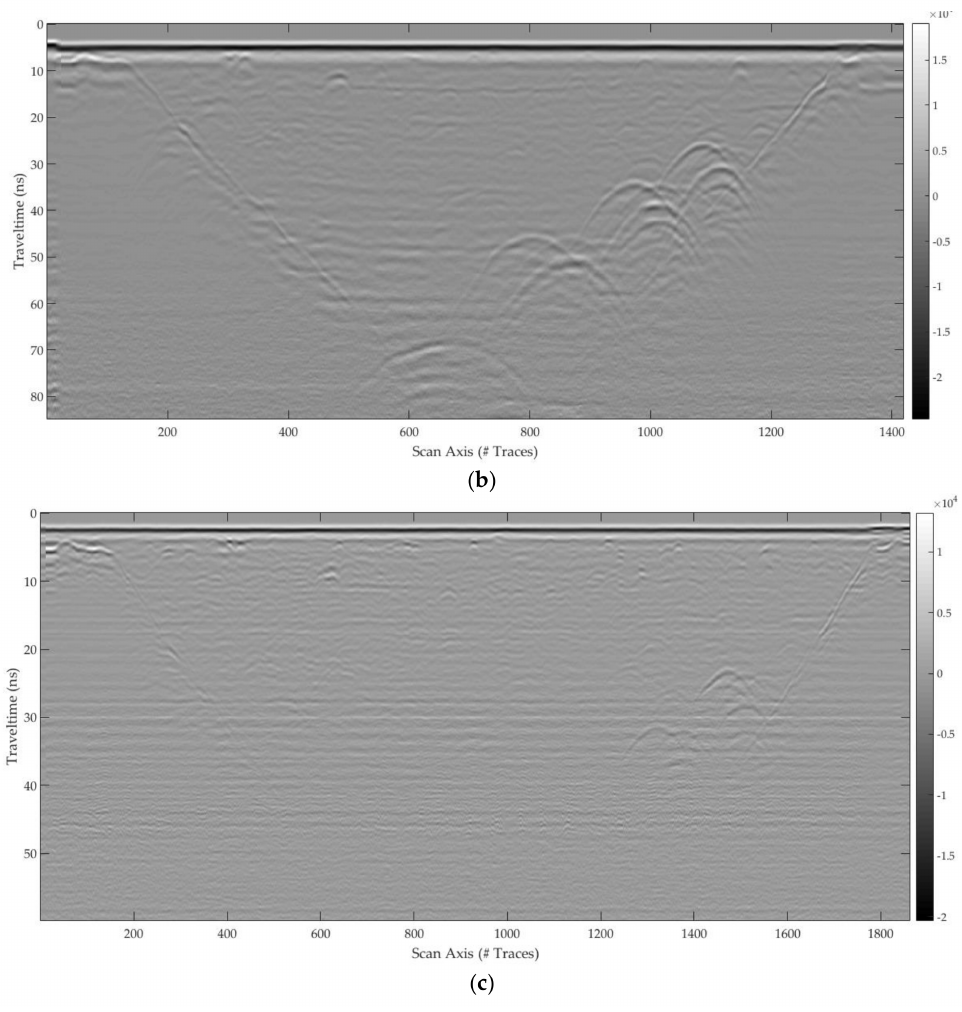
Figure 24. Profiles recorded in the limestone region by using GPR 1, on acquisition line 2, with antennas operating at: ( a ) 200 MHz; ( b ) 400 MHz; ( c ) 900 MHz.